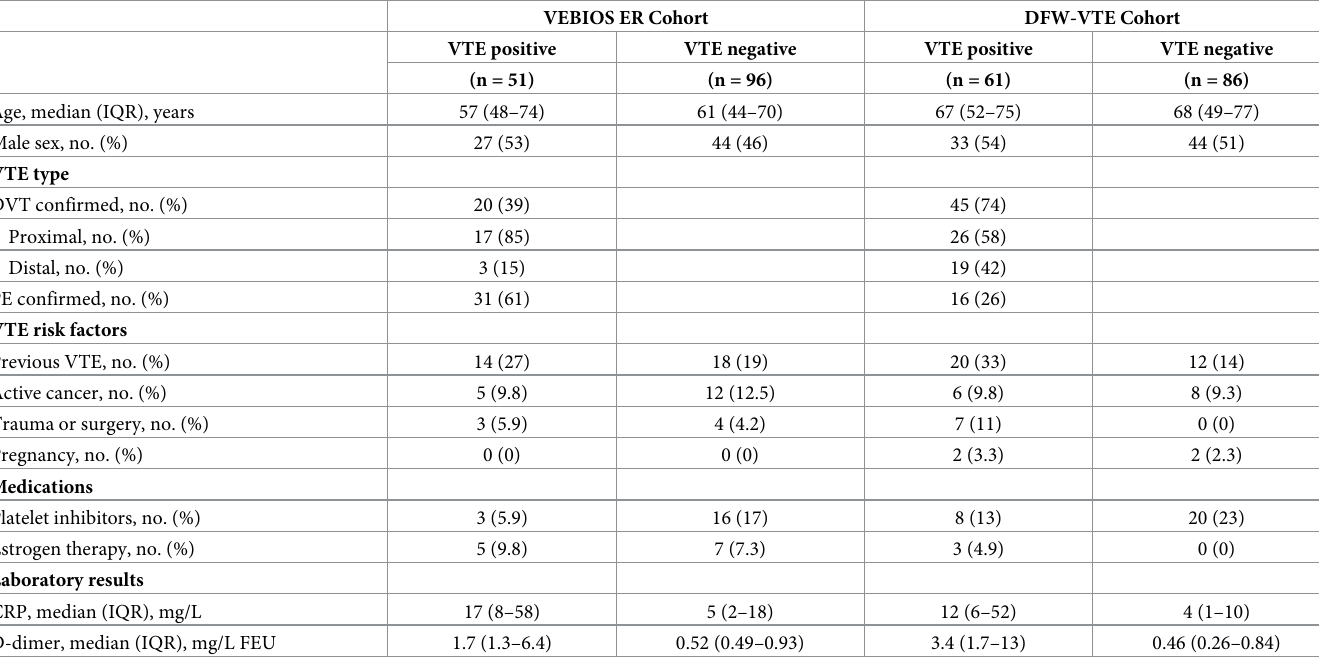
Table 1. Demographic data, clinical characteristics and routine laboratory results of study participants.